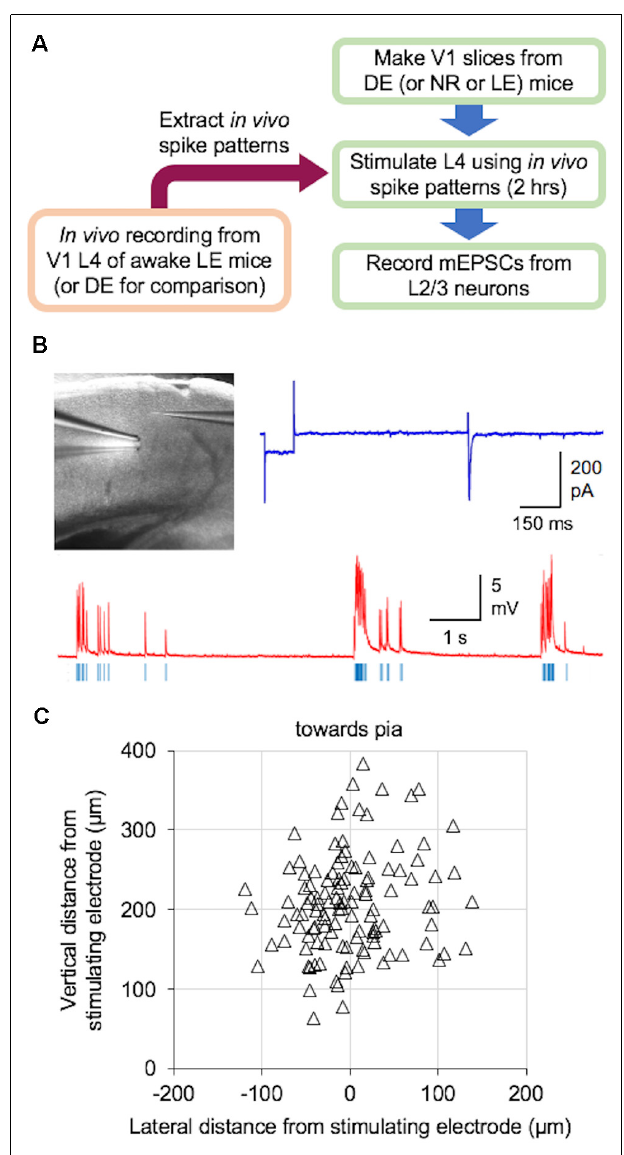
FIGURE 2 | Ex vivo paradigm to examine plasticity outcome following naturalistic spike pattern stimulation. (A) Schematic diagram of the experiments. In vivo spike trains were recorded from V1 L4 of awake head-fixed mice that were dark-exposed and brought out to light (LE) to view drifting gratings (+Pattern) or an equal luminance gray screen (+Gray). A group of DE mice was recorded in the dark (DE) for comparison. Recorded spike trains were analyzed to extract inter-spike-interval (ISI) information, which was then used to construct the stimulus train. V1 slices were obtained from DE [or normal reared (NR) or LE] mice. L4 of these slices were stimulated with the in vivo spike pattern for 2 h. Stimulus intensity was adjusted to produce subthreshold activation of L2/3 neurons (see B ). After the 2-h stimulation, miniature excitatory postsynaptic currents (mEPSCs) were recorded from L2/3 pyramidal cells under whole-cell voltage clamp. (B) Ex vivo experimental setup in acute V1 slice preparation. Top left: image of a V1 slice with a stimulating electrode in L4 and a whole-cell recording electrode patched onto a L2/3 pyramidal cell. Top right: an example voltage-clamp trace recorded when determining the stimulation intensity, which was adjusted to induce approximately 200 pA evoked excitatory